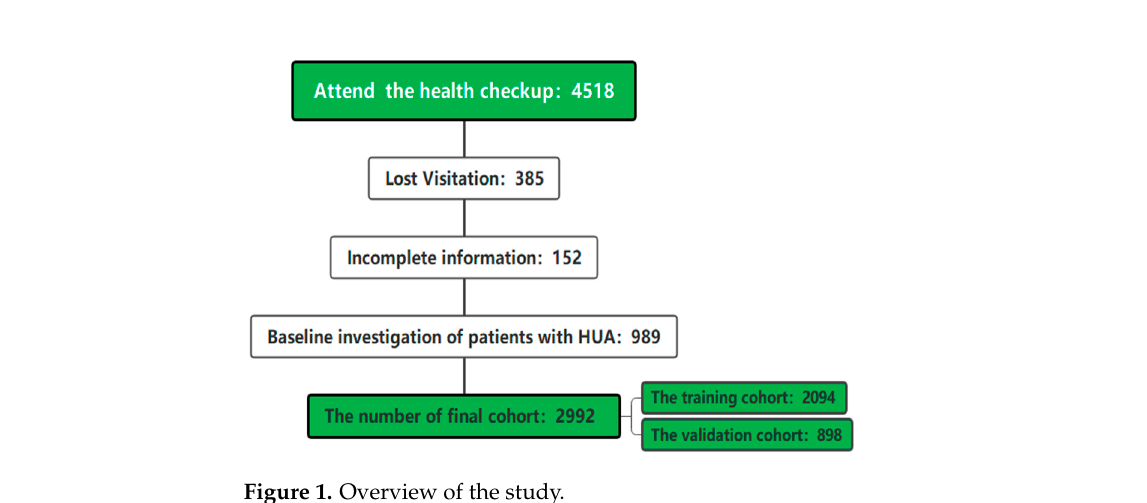
Figure 1. Overview of the study. Table 1. Characteristics analysis of